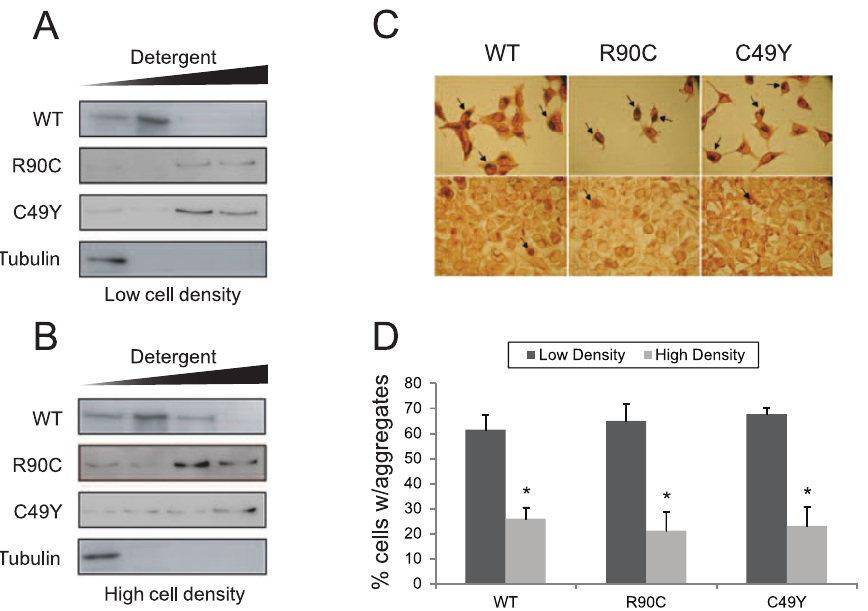
Figure 4. Detergent solubility and formation of inclusions of NOTCH3 expressed in cell culture. NOTCH3 complexes containing wildtype protein or mutant proteins were tested for detergent solubility. Total protein from cell lines expressing WT or mutant NOTCH3 were sequentially extracted as detailed in methods, using progressively higher strengths of detergents. Cells were grown at low density (A) or in confluent monolayers (B). While WT protein was modestly soluble, the mutant proteins were extractable only in higher detergent concentrations. NOTCH3 protein was detected using antisera from Santa Cruz. The control protein tubulin was readily extractable without detergents. Experiments were performed three times with consistent results. Cell lines were immunostained with the same antisera or with antibodies from R&D, revealing diffuse cell staining with focal accumulations in the perinuclear areas of cells expressing both wildtype and mutant proteins (C). A significant difference in the percentage of cells with perinuclear expression of the protein was notable at low cell density (D) (over 250 cells were counted for each cell line and condition. Results were reproduced three times, and significance was considered p , 0.05.